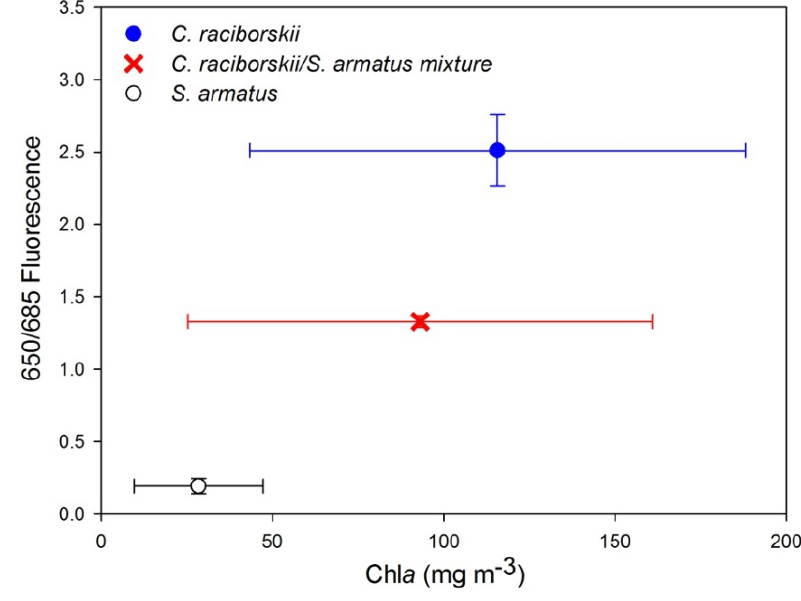
Figure 6. Discrimination of phytoplankton cultures, Cylindrospermopsis raciborskii and Scenedesmus armatus , through the ratio of fluorescence emission at 650 nm to that at 685 nm (excitation laser pulse wavelength = 355 nm; F = 18.68; p < 0.002). Averages shown by symbols, bars report ± standard error.